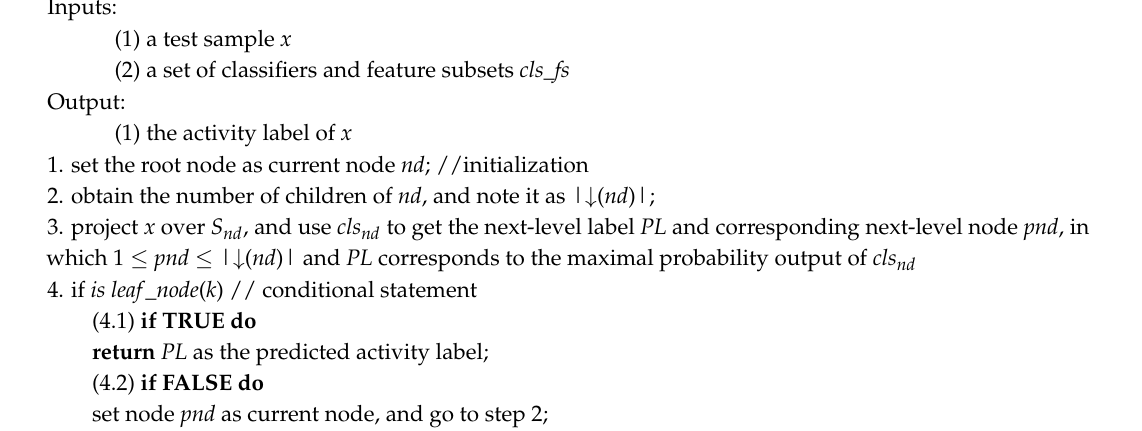
Algorithm 2. The Pseudo-code of Activity Recognition Using the Hierarchical